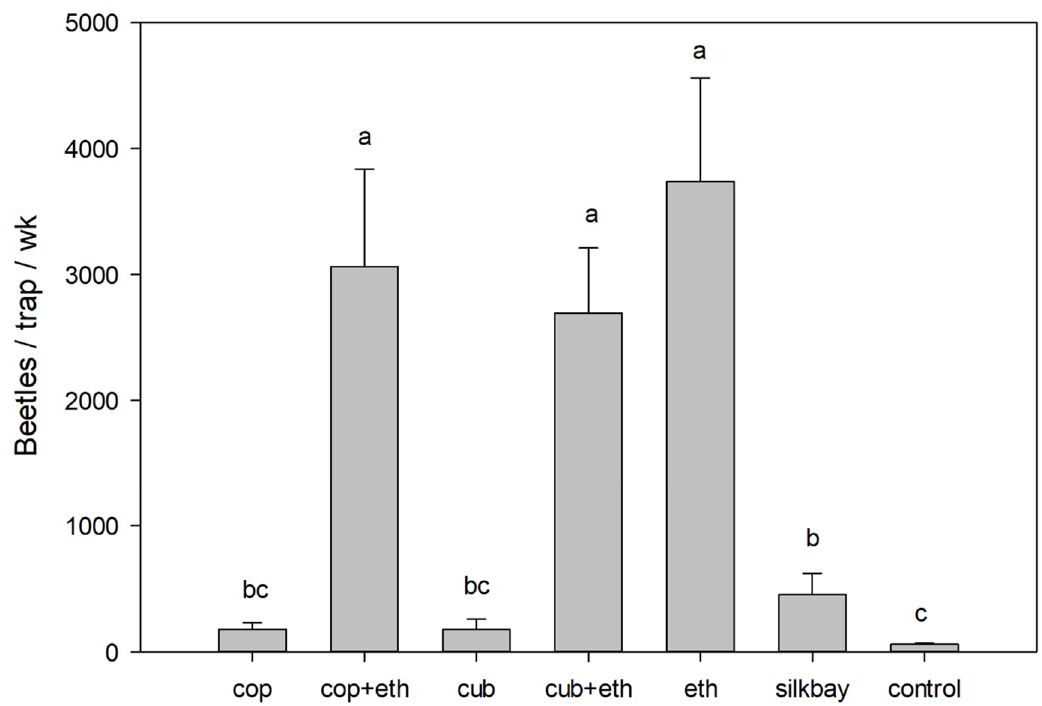
Figure 4. Mean ( ± SEM) captures of bark and ambrosia beetles (all species summed) in a 7-wk Figure 4. Mean (± SEM) captures of bark and ambrosia beetles (all species summed) in a 7-wk field field test conducted in a commercial avocado grove with laurel wilt, Miami-Dade County, Florida. Table 50. α -copaene lures (cop), cubeb oil lures (cub), low-release ethanol lures (eth), combinations Treatments consisted of white sticky panel traps baited with 50% α -copaene lures (cop), cubeb oil of essential oil lures and ethanol lures (cop + eth; cub + eth), bolts of silkbay ( Persea humilis ), and lures (cub), low-release ethanol lures (eth), combinations of essential oil lures and ethanol lures non-baited traps (control). Bars topped with the same letter are not significantly different (Tukey (cop + eth; cub + eth), bolts of silkbay ( Persea humilis ), and non-baited traps (control). Bars topped HSD mean separation, p < 0.05). with the same letter are not significantly different (Tukey HSD mean separation, p <